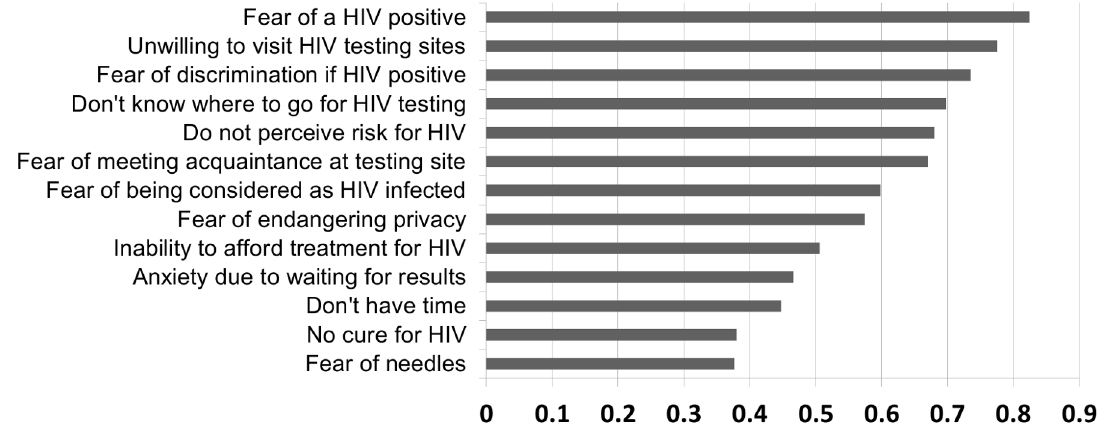
Figure 2. Self-reported barriers for HIV testing among 495 MSM who took clinic-based testing in a contemporaneous parallel study (Li X, etal [9]